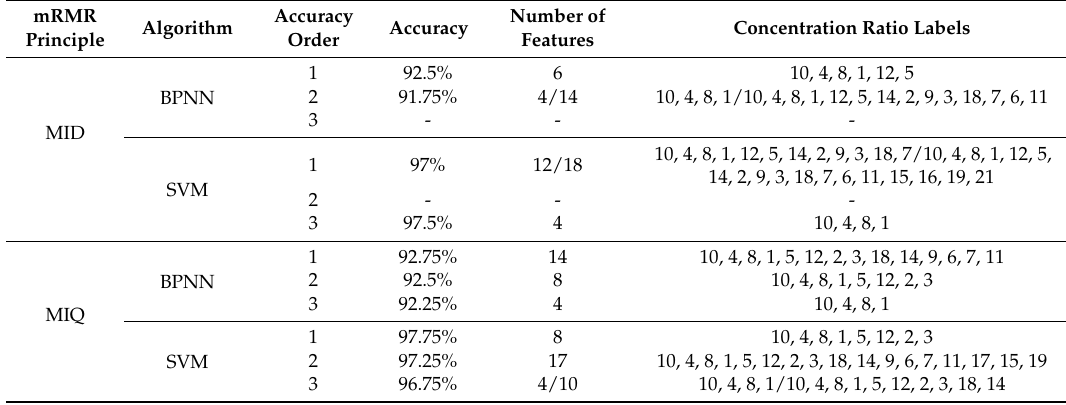
Table 5. The highest three prediction accuracies and their corresponding concentration ratios.